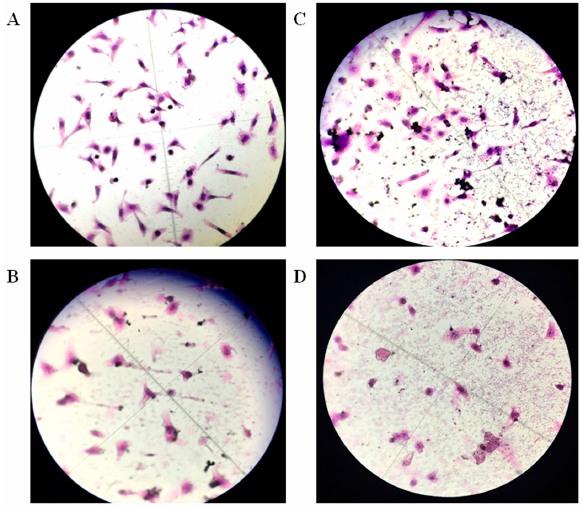
Figure 4. Hematoxylin-eosin (HE) staining to observe the effect of different concentrations of ellagic acid microspheres on HepG2 cell proliferation: ( A ) Control group; ( B ) 0.1 g/L ellagic acid microspheres; ( C ) 0.3 g/L ellagic acid microspheres; ( D ) 0.5 g/L ellagic acid microspheres (100 ×